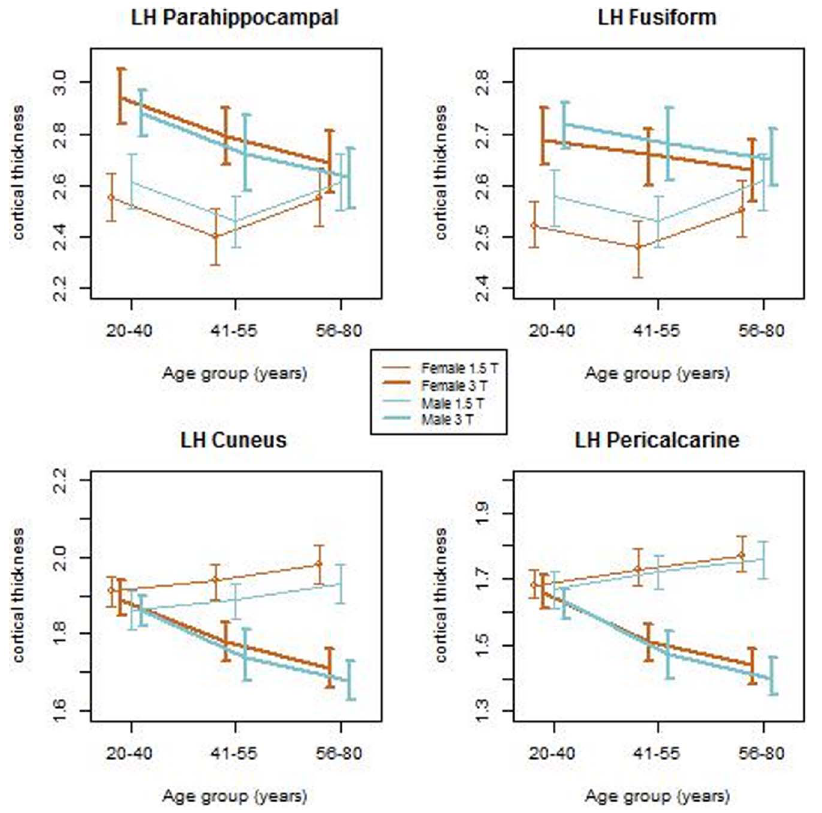
Figure 5. An example of the variation of cortical thickness for three age groups for males and females at 1.5 T and 3 T. The following regions in left hemisphere are shown in this plat: parahippocampal, fusiform, cuneus and pericalcarine